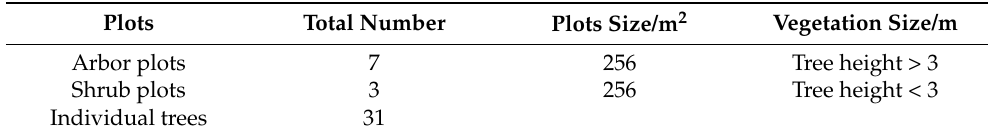
Table 2. The details of sample plots.